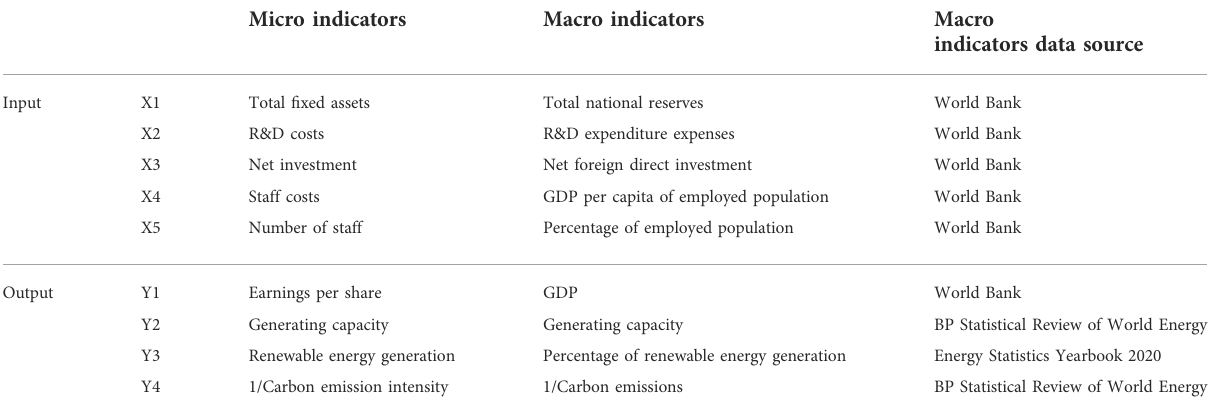
TABLE 3 Indicator